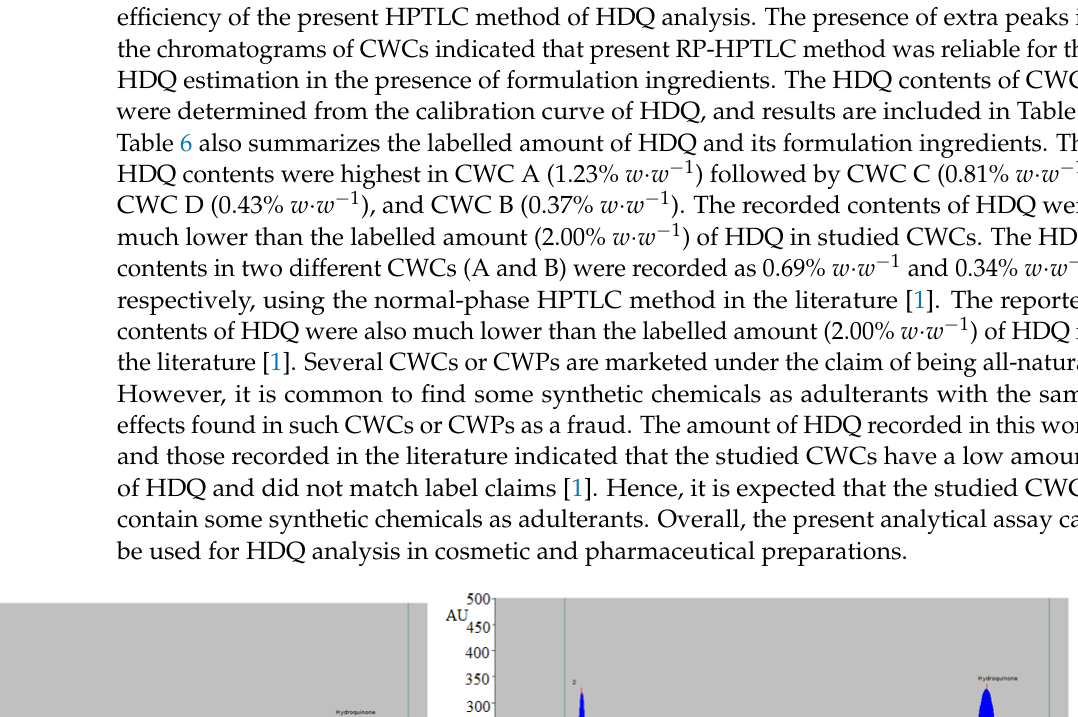
Table 6. Determination of HDQ in four different commercial whitening creams (CWCs) using an ecologically sustainable HPTLC method (mean ± SD; n = 3) .